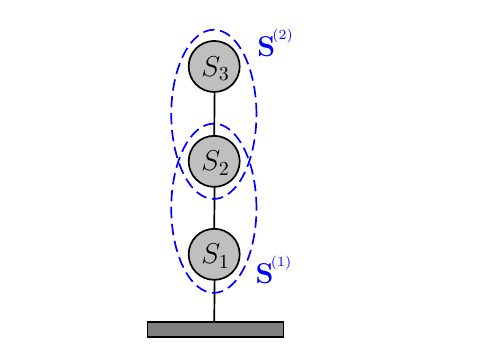
Figure 1: Overlapping decomposition for a three-story